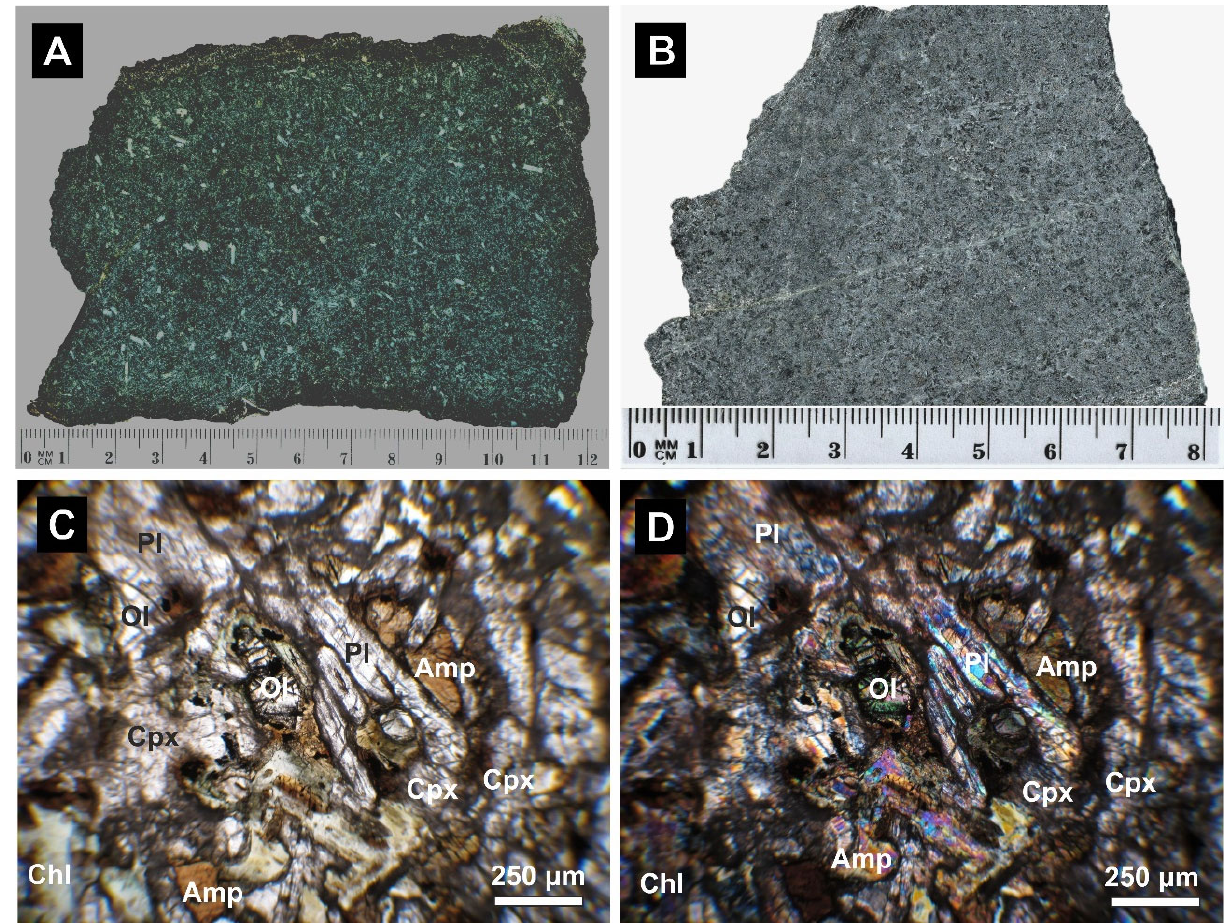
Figure 16. Macroscopic (A,B) and PL microscopic ( C , D ) images of dolerites. ( A ) Cpx ‐ Pl ‐ Amp dolerite (P17C). ( B – D ) Ol ‐ Opx ‐ Cpx ‐ Amp–Pl dolerite (P9). Picture ( C ) at II P; ( D ) at X P.